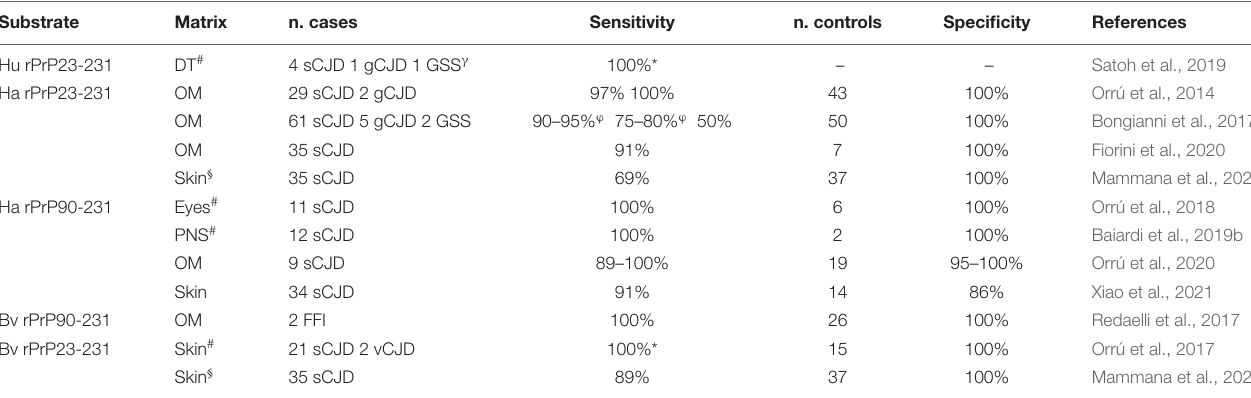
TABLE 4 | Performance of RT-QuIC in peripheral tissue matrices from definite and/or probable cases and controls (not-CJD and/or healthy). Substrate Matrix n. cases n.